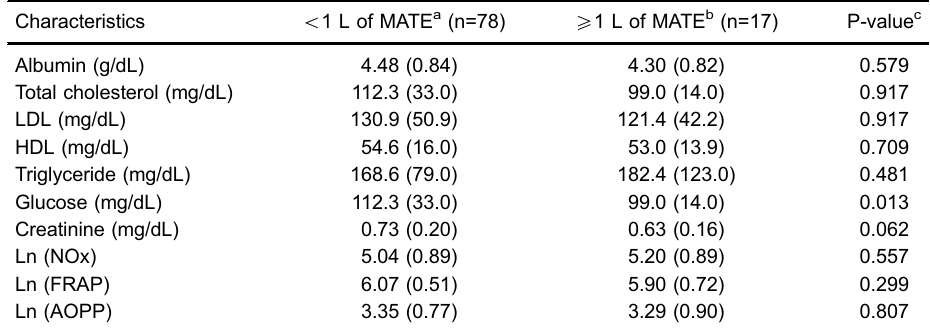
Table 2. Laboratory characteristics of the studied women according to their daily intake of yerba mate.